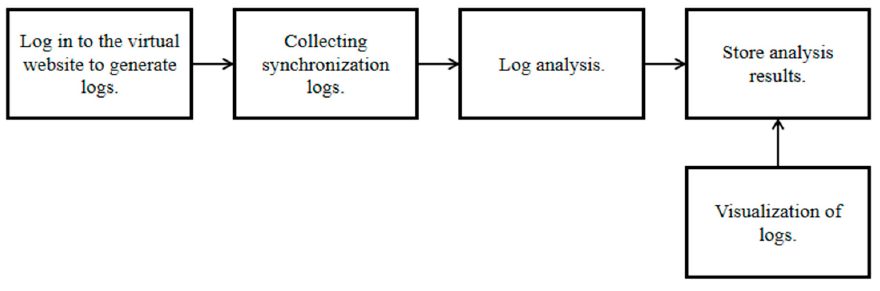
Figure 1. The framework of flow chart.